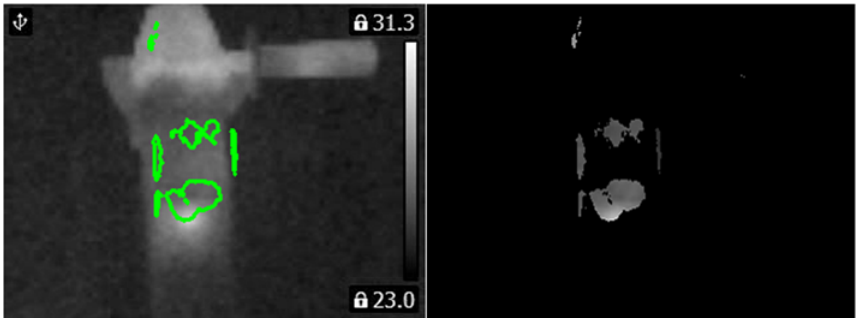
Figure 15. Binary image (0.5 < K < 1) of the matrix K. Computed matrix V for the healthy angle grinder was presented in Figure 16. Histograms and PCA values for the healthy angle grinder were presented in Figure 17.